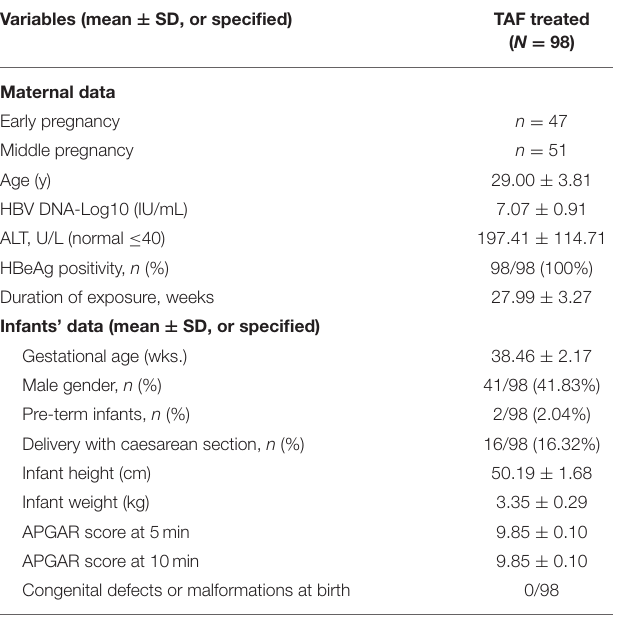
TABLE 1 | Maternal and infant baseline values.